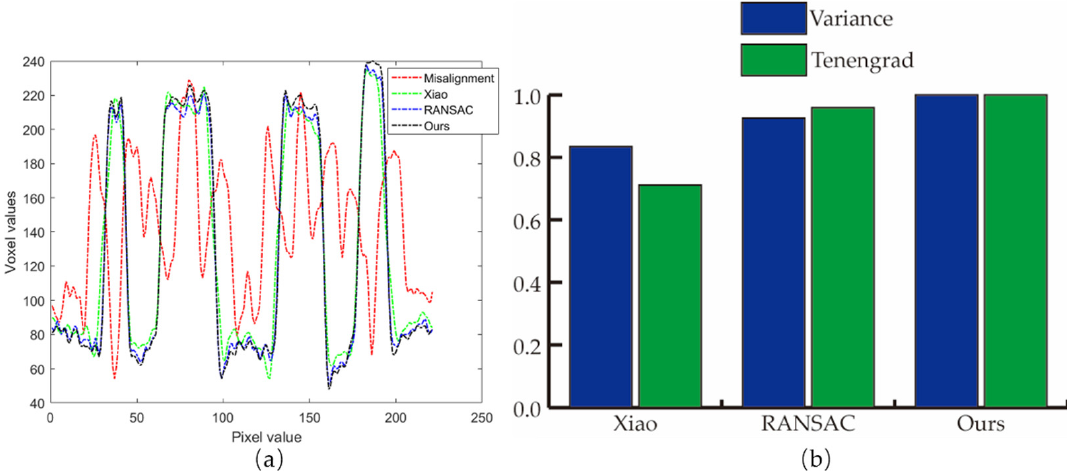
Figure 9. Graphs showing the numerical analysis results for reconstructed image quality. ( a ) The green line corresponds to the pixel value; ( b ) Normalized evaluation results for Variance and Tenengrad.